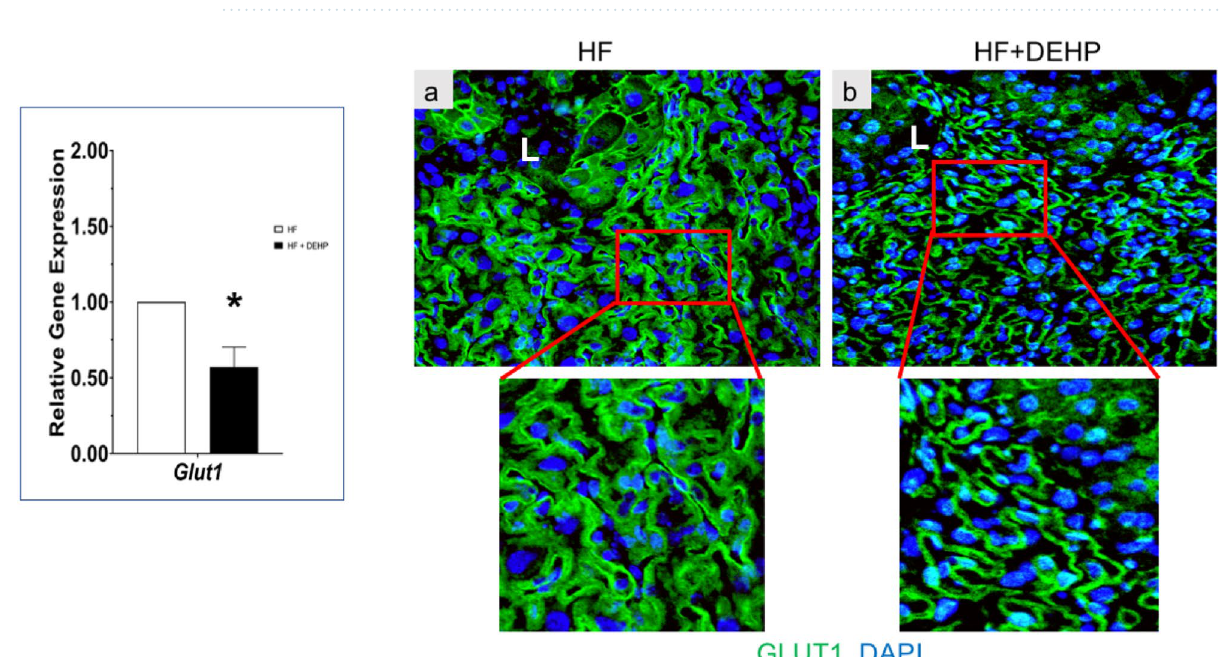
Figure 6. GLUT1 expression is attenuated in trophoblast cells in response to DEHP and HF diet. Left. Expression of Glut1 in placental labyrinth from HF and HF + DEHP animals. Total RNA was isolated from the placenta on D13 of pregnancy and qPCR analysis was performed using primers specific for Glut1 . Data represent mean ± SEM from four separate samples. Asterisks indicate statistically significant differences *p < 0.05. Right. GLUT1 immunostaining of placental labyrinth from HF (panel a ) and HF + DEHP ( b ) animals on D16 of pregnancy are shown (20×). Lower panels indicate magnified images of the boxed areas. Green indicates immunostaining with GLUT1 and blue indicates DAPI. N = 5 for each group and representative images are